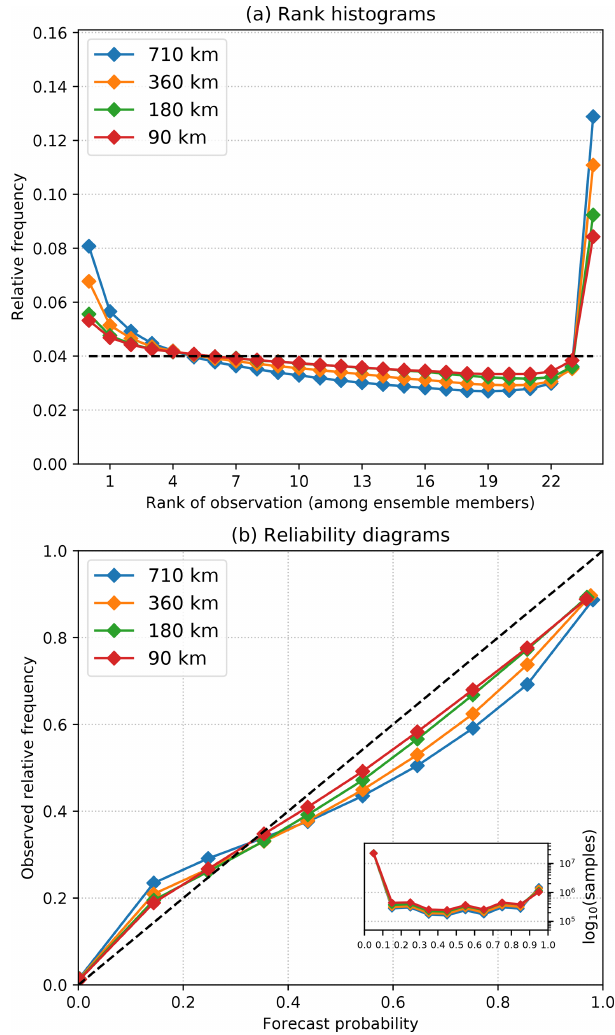
Figure 16. Effect of localization in terms of (a) rank histograms and (b) reliability diagrams computed for the 30min lead time and 1mmh − 1 during the MeteoSwiss events (Table 8). The localization window was reduced from the full domain (710km) to three differ- ent local scales (360, 180 and 90km).